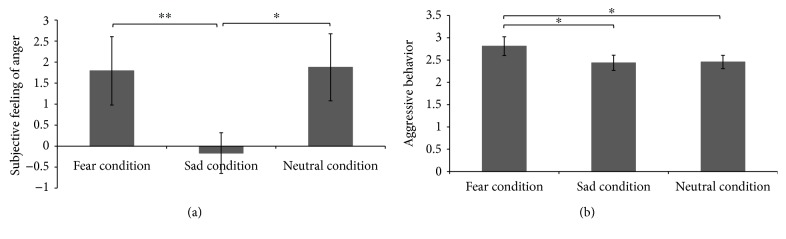
Comparison of the subjective feeling of anger and aggressive behavior under the fear, sad, and neutral conditions. The difference between the subjective anger feeling in each condition and that at baseline is shown in (a). The aggressive behavior under the three conditions is shown in (b). The error bars (capped vertical bars) represent (−1)/(+1)SE. ∗∗ indicates a significant difference at p < 0.01; ∗ indicates a significant difference at p < 0.05.